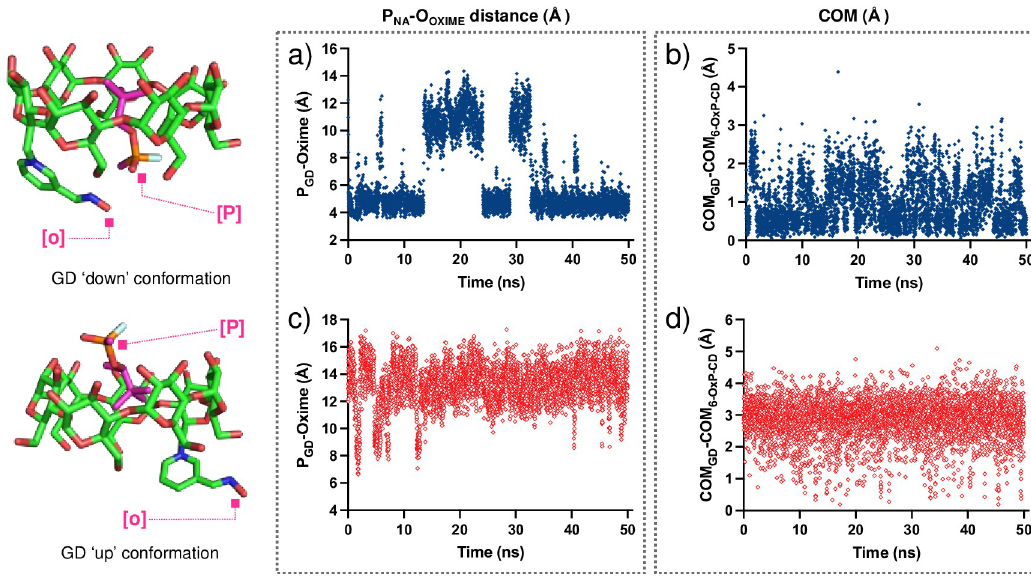
Simulations on the VX:6-OxP-CD complex and VX:6-OxP- α -CD Modeling of VX in the interior of 6-OxP-CD did not suggest the formation of a stable inclu- sion complex. It was found that in only 1 out of the 20 simulations performed the VX molecule